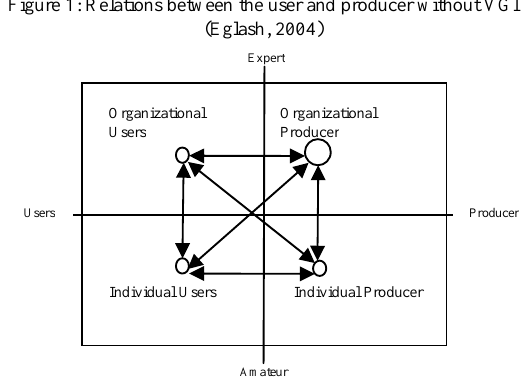
Figure 1: Relations between the user and producer without VGI (Eglash, 2004)